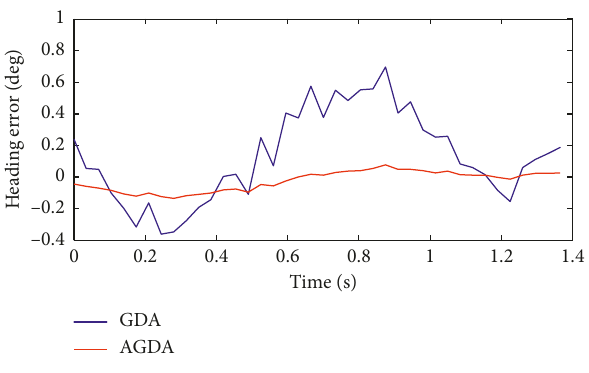
Figure 8: Heading angle error results.